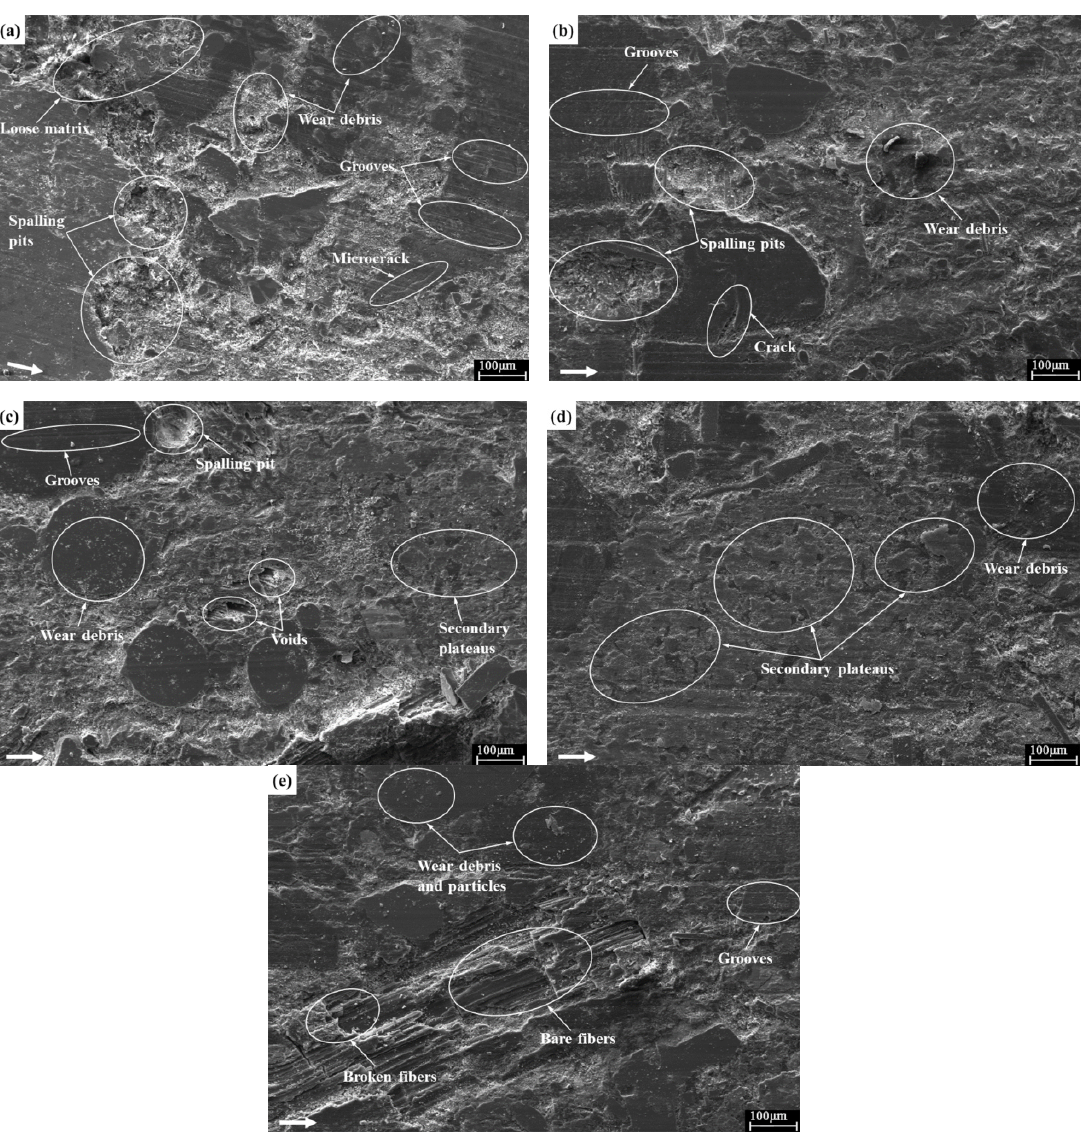
Figure 7. Worn surface morphology of ( a ) FC-0; ( b ) FC-2; ( c ) FC-4; ( d ) FC-6; ( e ) FC-8.